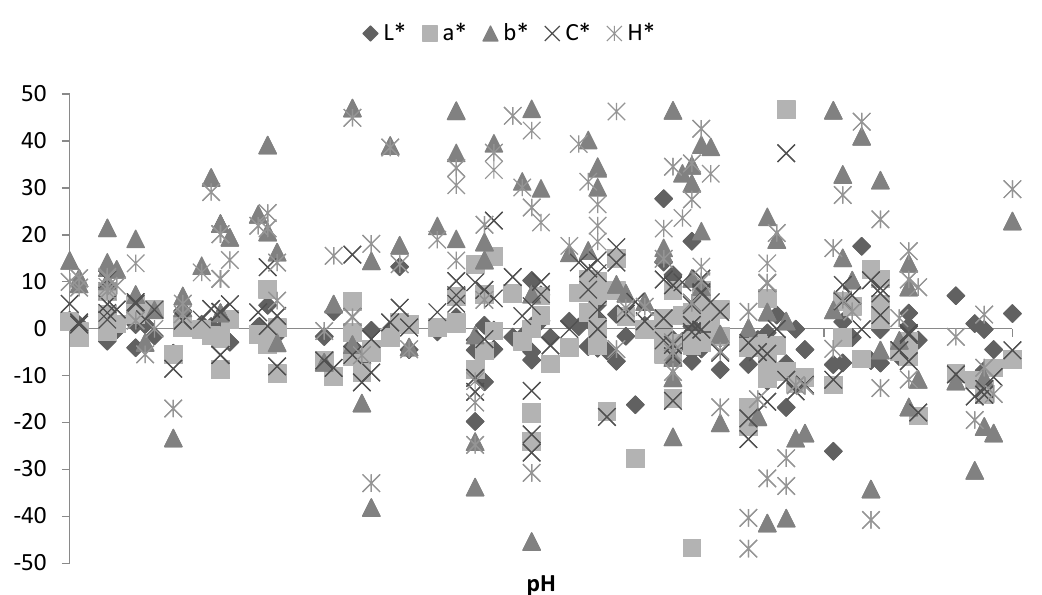
Figure 2. The percentage increase/decrease of color parameters during bloom time depending on the muscle type. LD— Longissimus dorsi , LL— Longissimus lumborum , IL— Iliacus , SEM— Semimem- branosus , CT— Cutaneous trunci , LTD— Latissimus dorsi . Figure 3 presents the dependence of percentage color change on pH parameters after 30 min bloom time without the division for muscles. A general tendency emerging from individual observations does not indicate any unambiguous dependence in this respect. Therefore, there seems to be no dependency between bloom time effect and the changing muscle pH, nor the interaction of these two main effects. The greatest dispersion was recorded for the b* and H* parameters. On the other hand, the highest stability was observed for the L* and a* parameters.